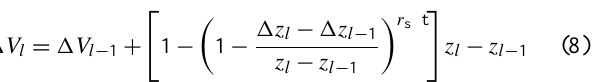
Table 2. Fitted parameters for cumulative volume change outside the structural shrinkage phase at field A in 2011, where 1V = a1W + b , goodness of fit R 2 between fit and observations, and observed water loss in the structural shrinkage phase S obs . Parameters a 0 , b 0 and R 2 are fitted after applying r s (θ)